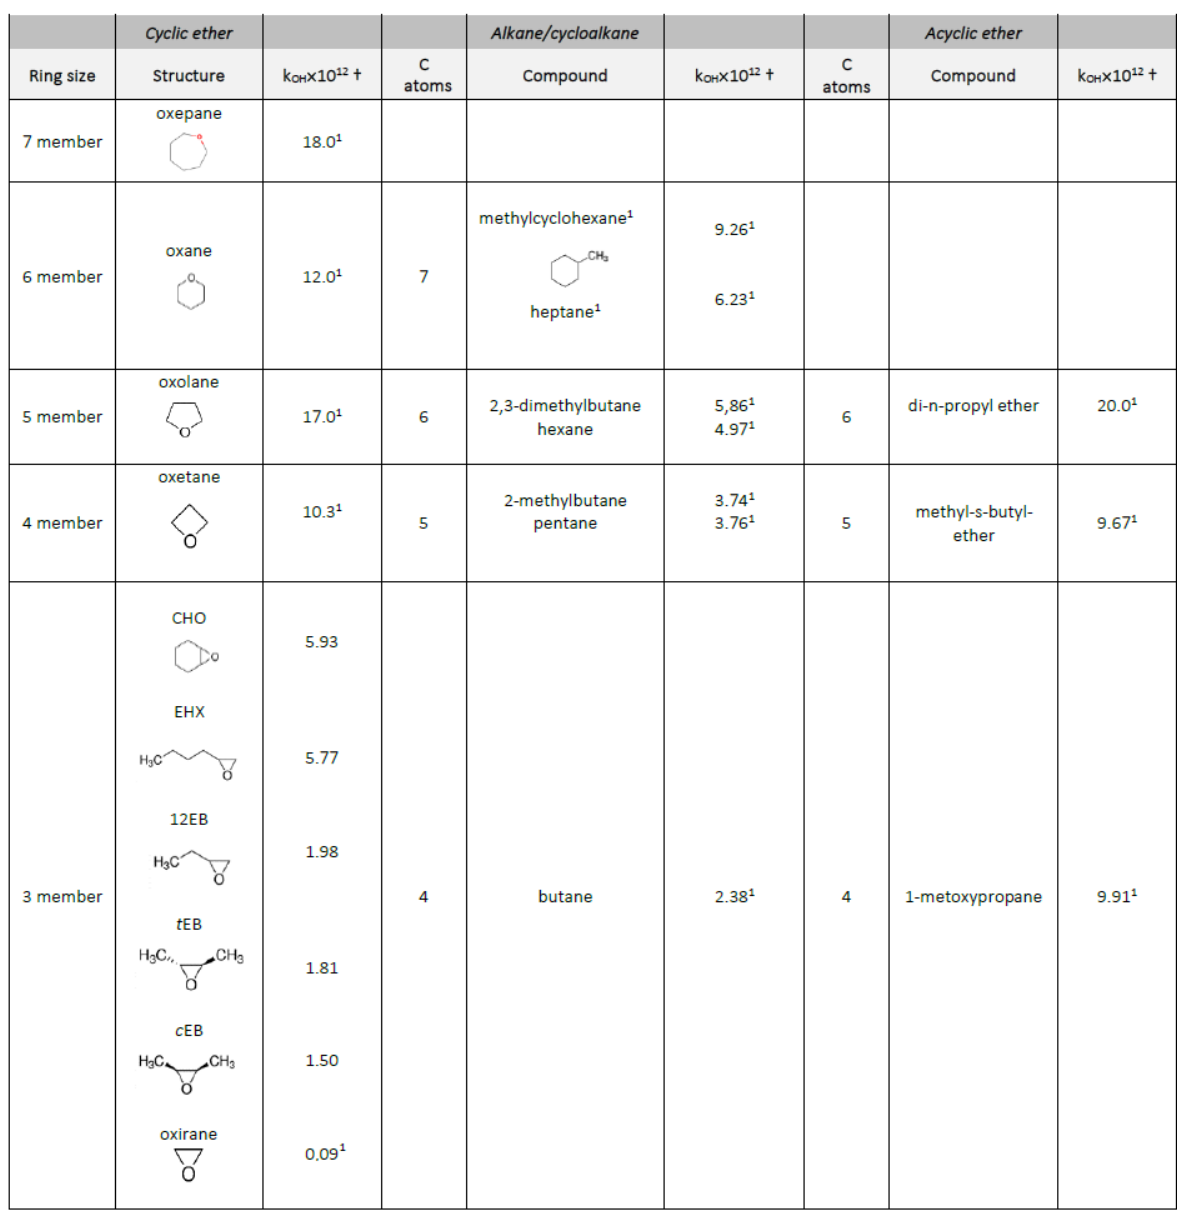
Table 4. Reactivity trends of the epoxy compounds towards OH radicals compared with their homologous alkanes, acyclic ethers and cycloalkanes with the same number of carbon